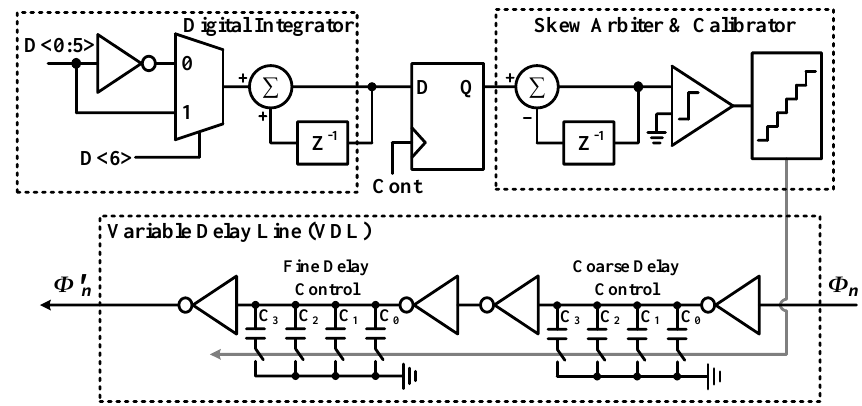
Figure 14. Block diagram of the proposed timing-skew calibration.